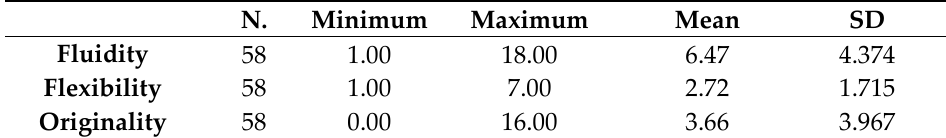
Table 3. Mean Scores of the Toy Improvement Task .